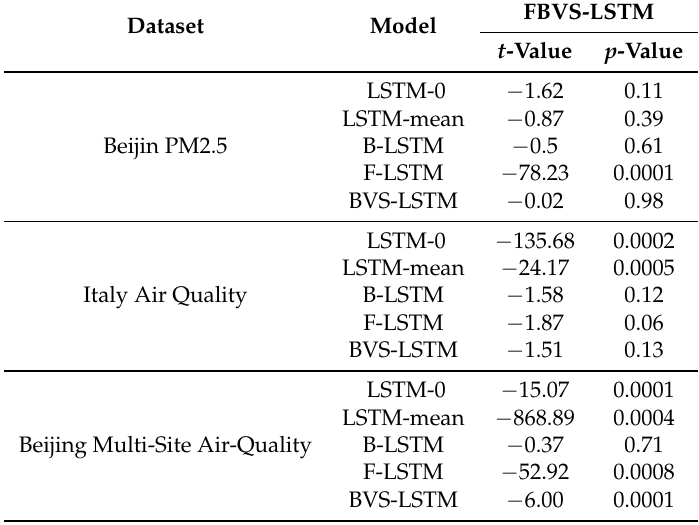
Table 4. Statistical analysis with t